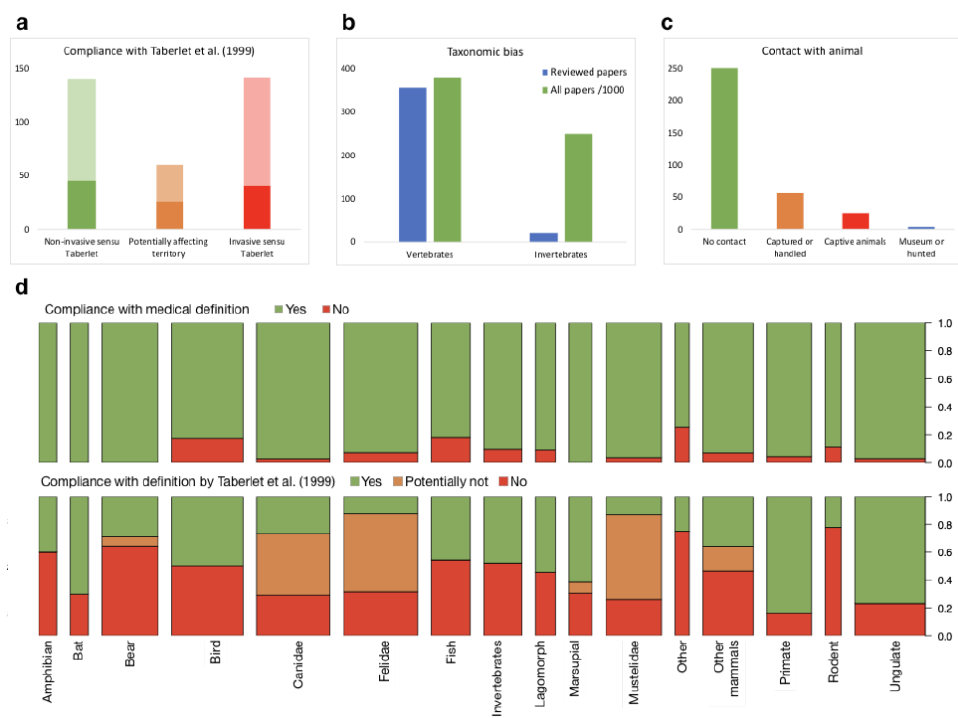
Figure 2. Summary statistics of the main issues exposed by our literature review on the use of “non - invasive DNA sampling” between January 2013 and December 2018 (n=380). For a, b, and c, the y-axis is the number of papers. For d, the y-axis is the proportion of papers and the width of the bars is proportional to the number of papers for each taxonomic group. a: Compliance of papers with the original definition proposed by Taberlet et al. (1999). Studies where multiple methods were used (n=31) were classified as compliant with the definition by Taberlet et al. (1999) only if all the methods used were compliant OR if invasive sampling methods were clearly identified by the authors. Dark colours correspond to papers where the phrase “non - invasive” was present in the title, lighter colours correspond to papers where the phrase “non - invasive” was not present in the title. The orange bar (labelled as “potentially affecting territory”, corresponds to cases where territory marking and social interactions may have been affected by the removal of faecal samples. b : Taxonomic bias in the non- invasive DNA sampling literature. Number of papers reviewed that focus on invertebrates or vertebrates compared to all papers on invertebrate or vertebrate (see Method section for search command). c : Number of papers complying (in green) or not complying with the no contact criteria proposed by Taberlet et al. (1999), because animals were either captured or handled for DNA sampling (orange), held in captivity (red) or had been killed (blue). d : Proportion of papers complying with different definitions of non-invasive sampling in relation to the taxonomic group studied. Top: compliance with the common definition of a non-invasive medical or veterinary procedure, (i.e. one not involving puncture of the skin or other entry into the body (Miller & Keane, 1983). Bottom: compliance with the definition of non- invasive DNA sampling proposed by Taberlet et al. (1999). Orange boxes (labelled as “Potentially Not”) correspond to cases where territory marking and social interactions may have been affected by the removal of faecal